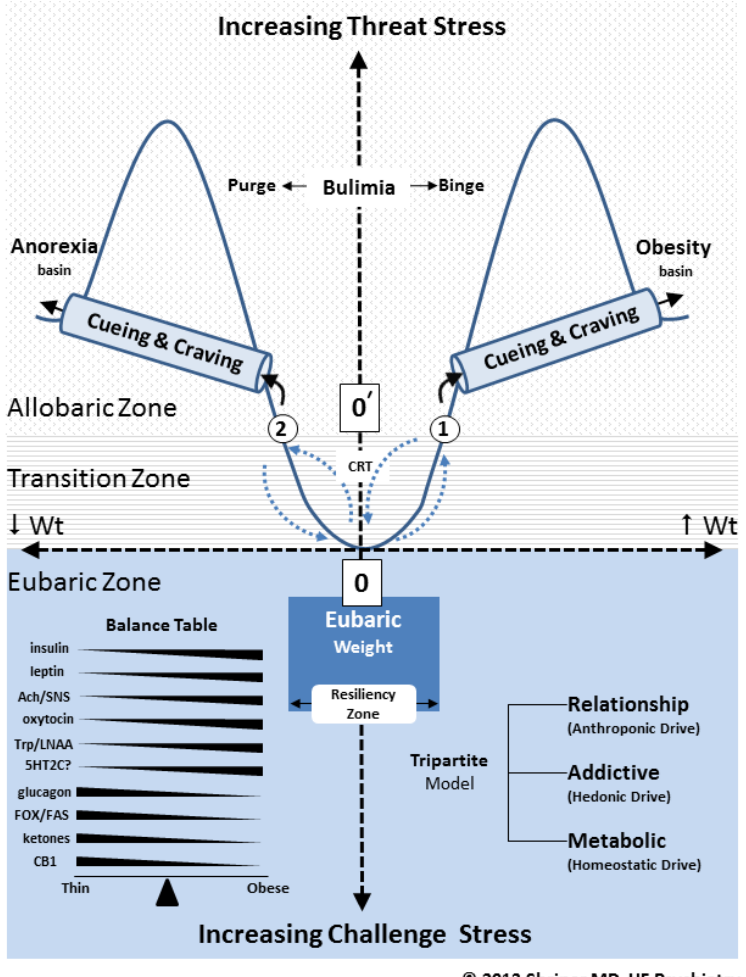
Figure 1. The SWEAM (a stress/weight matrix which stands for: Stress, Weight, Eubaric, Allobaric and Matrix) and Tripartite Models. Abbreviations: Ach (acetylcholine), SNS (sympathetic nervous system), Trp (tryptophan), LNAA (large neutral amino acids), 5HT2C (5-hydroxytryptophan 2 C), FOX (fatty acid oxidation), FAS (fatty acid synthesis), CB1 (endocannabinoid